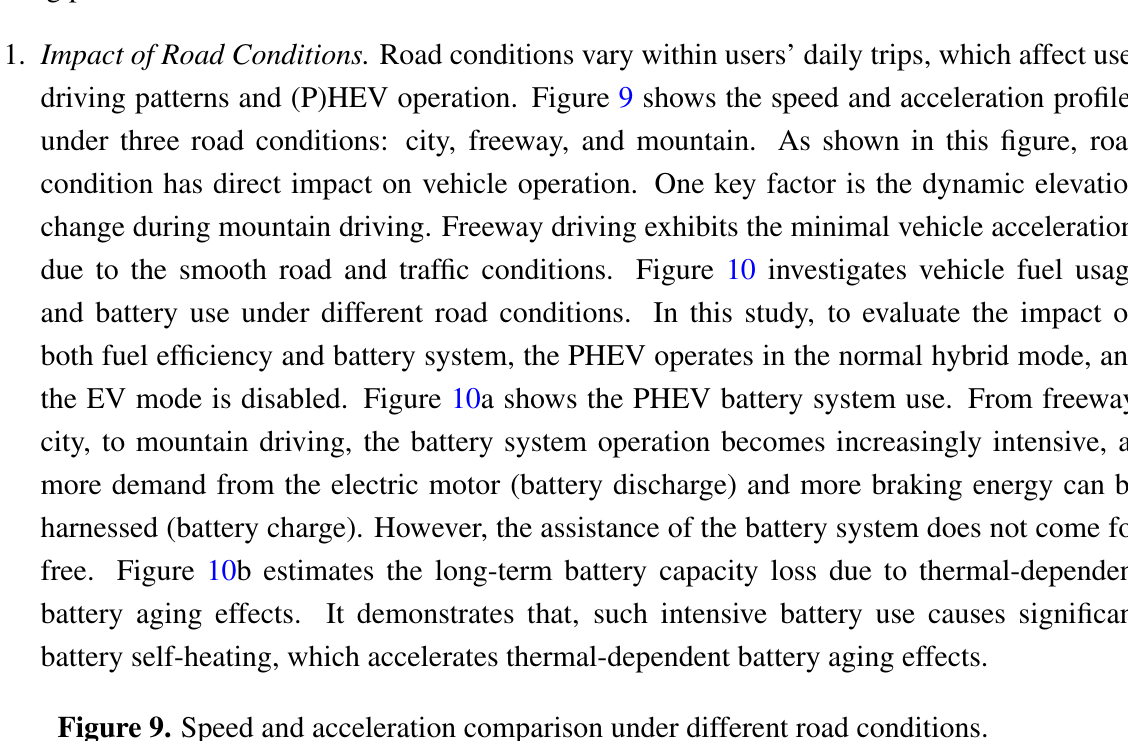
Figure 9. Speed and acceleration comparison under different road conditions.